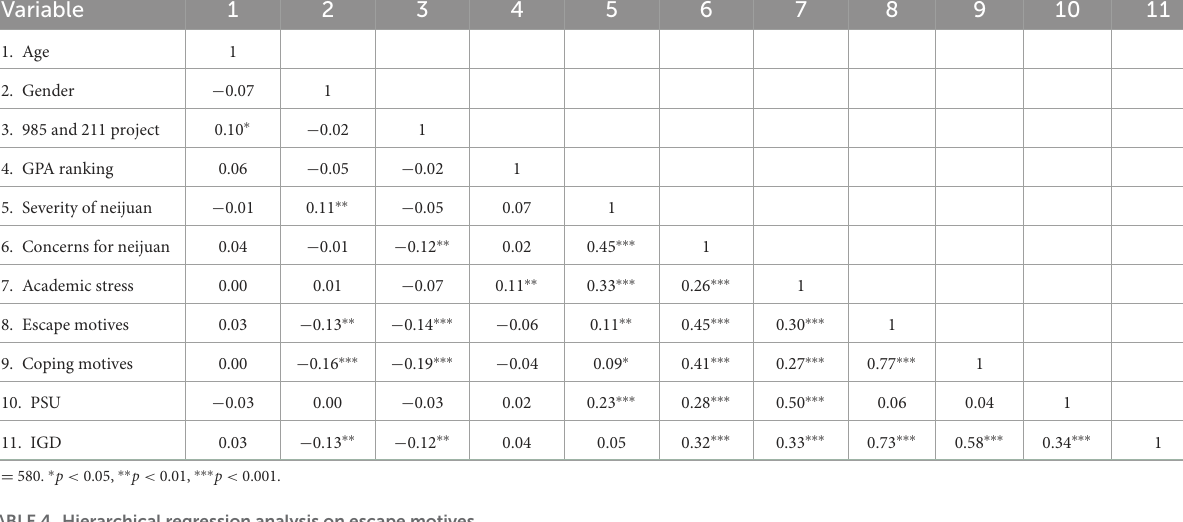
TABLE 4 Hierarchical regression analysis on escape